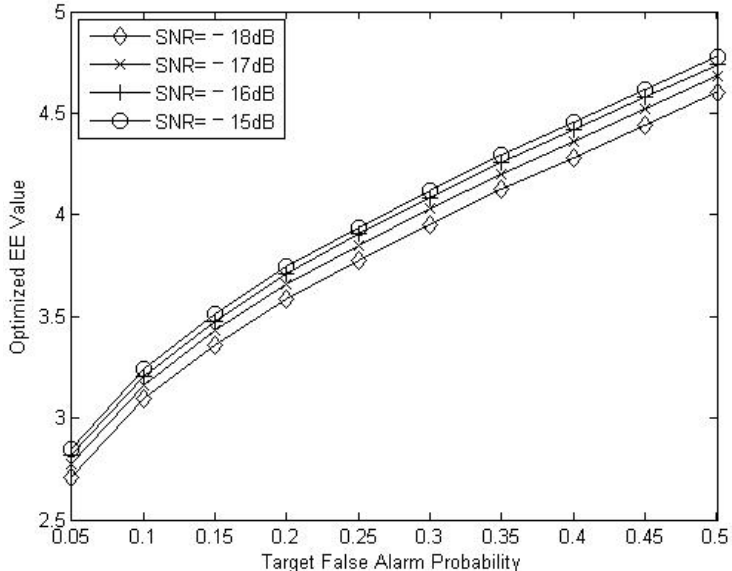
Figure 10. Optimal EE under target detection probability.